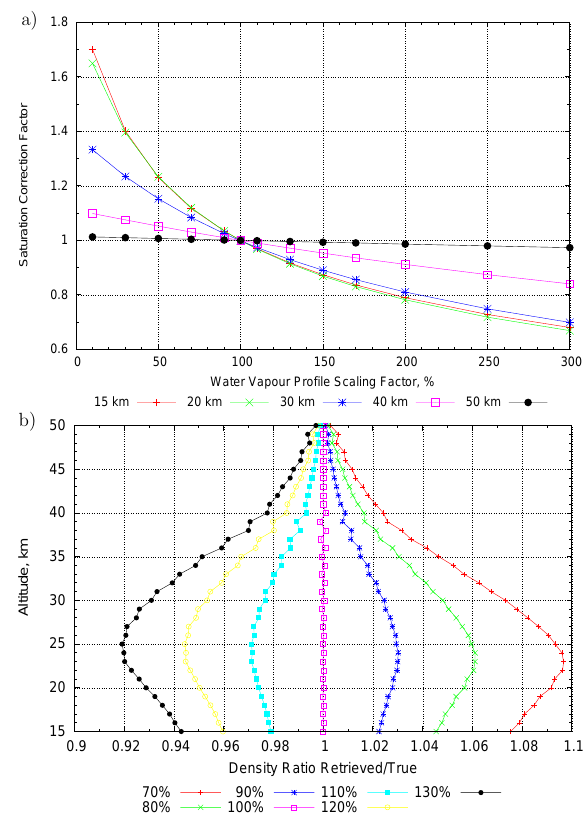
Fig. 3. Results for simulated data. (a) Saturation correction factors as function of the water vapour scaling factor for different tangent altitudes. (b) Results of a retrieval on simulated data using scaled water vapour profiles. The different curves correspond to different scaling